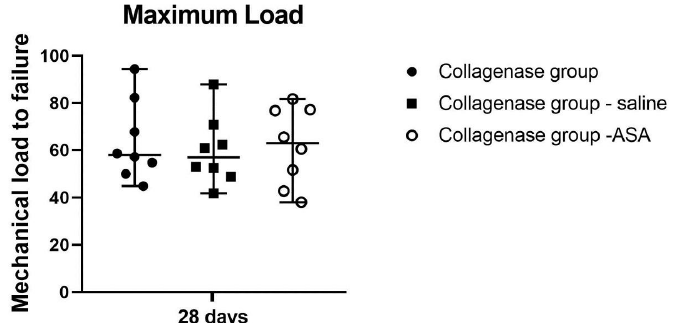
Figure 4. Biomechanical analysis for the treated groups. Maximum load for tendons in the collagenase/untreated, collagenase/saline, and collagenase/amniotic suspension allograft (ASA). Median with range reported.